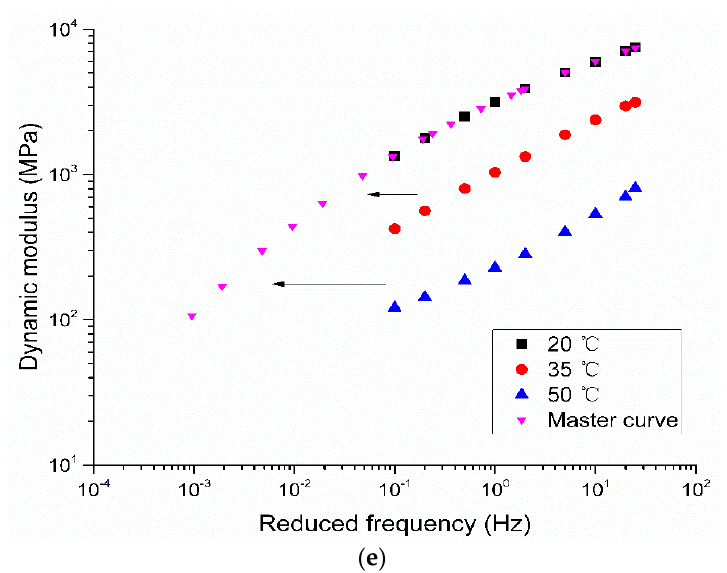
Figure 6. The master curves of dynamic modulus test results (reference temperature: 20 °C): ( a ) Group 1; ( b ) Group 2; ( c ) Group 3; ( d ) Group 4; ( e ) Group 5.